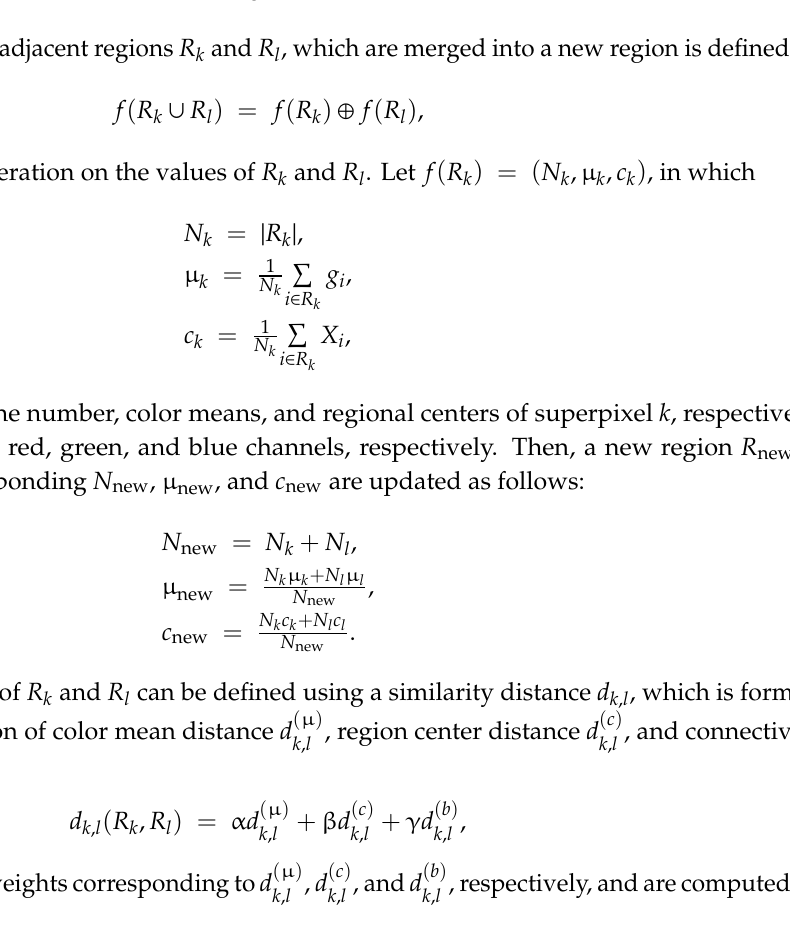
Figure 9. Region of interest (ROI) extraction on the top of the image pyramid by jointly using simple linear iterative clustering (SLIC) and Sobel algorithms: ( a ) UAV image pyramid; ( b ) the down-sampled image; ( c ) the result of SLIC segmentation in which two red superpixels are selected as seeds; ( d ) the gradient information detected using the Sobel algorithm; ( e ) the ROI, where blue and yellow denote the regions of water and barge, respectively.